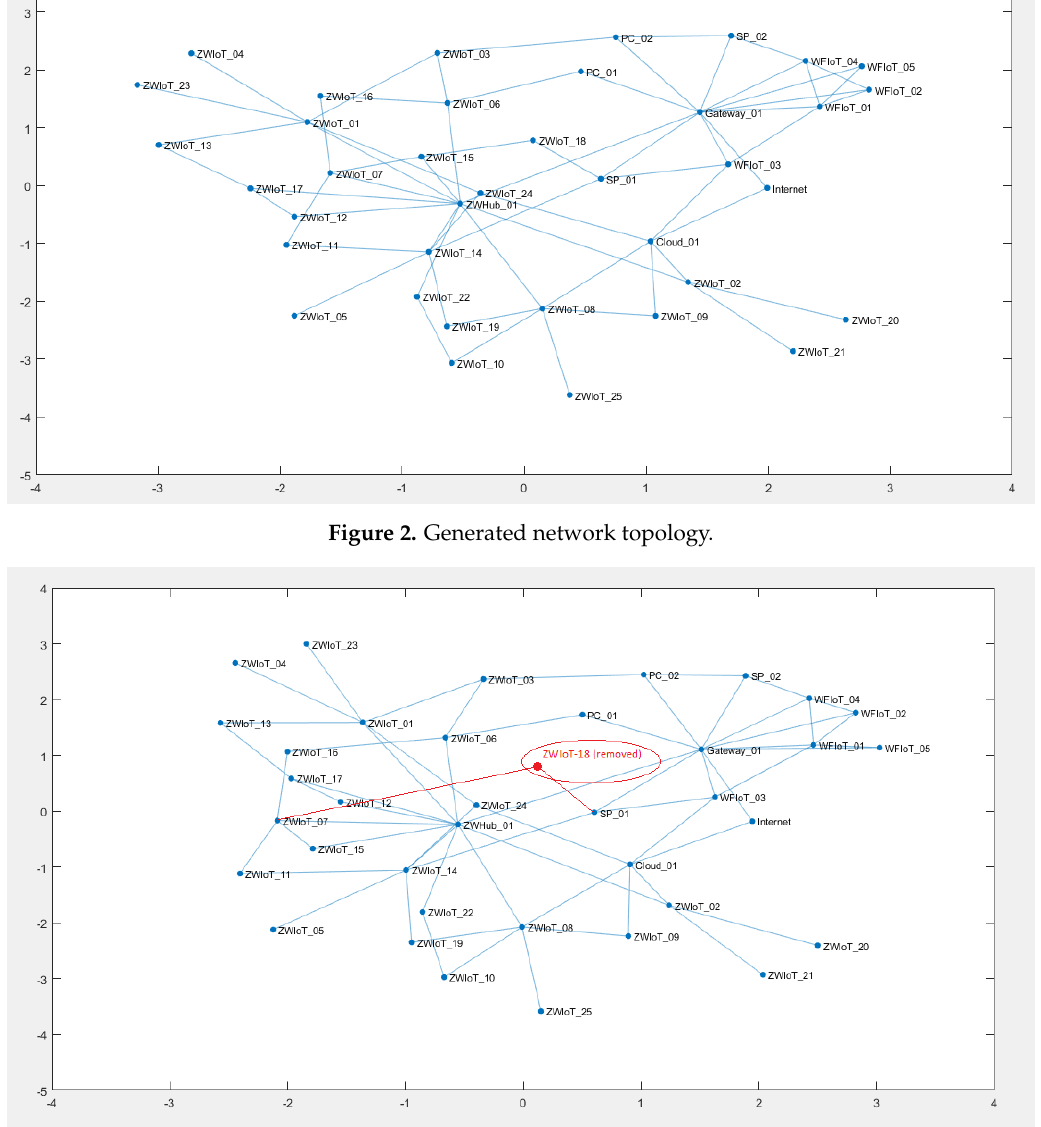
Figure 3. Node ZWIoT18 (in red) has been removed from the network topology. The connections the node had to ZWIoT15 and SP01 are also